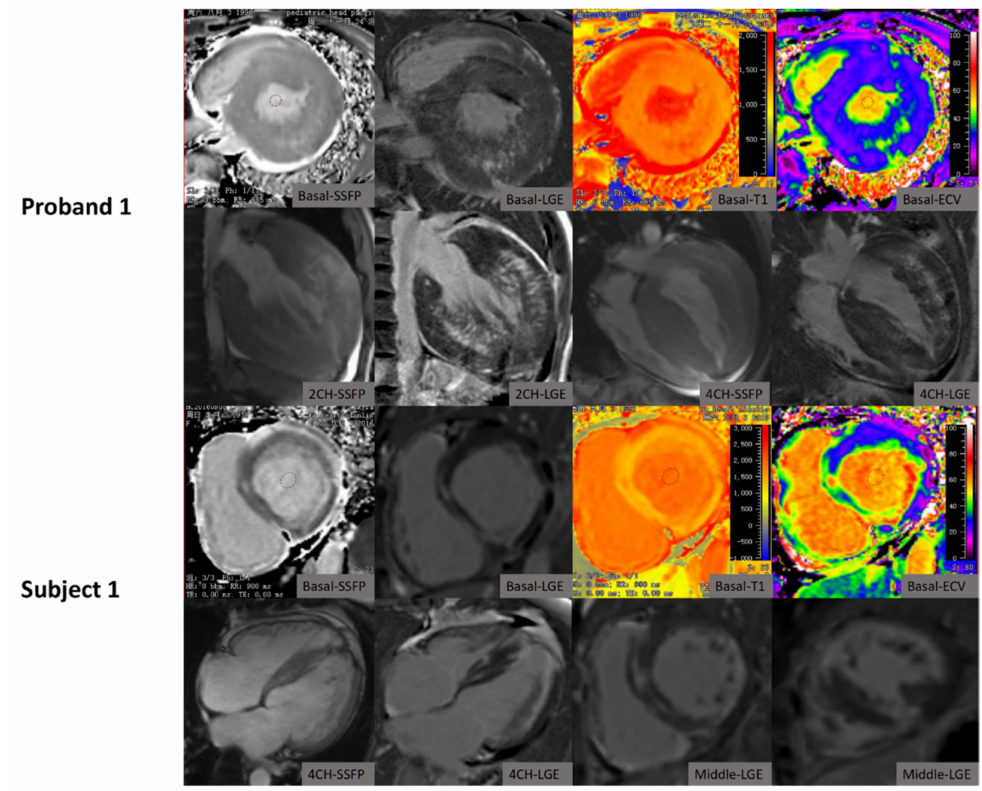
Figure 1. The characteristics of cardiac MRI in the proband 1 patient and the patient’s mother (Subject 1) with Danon